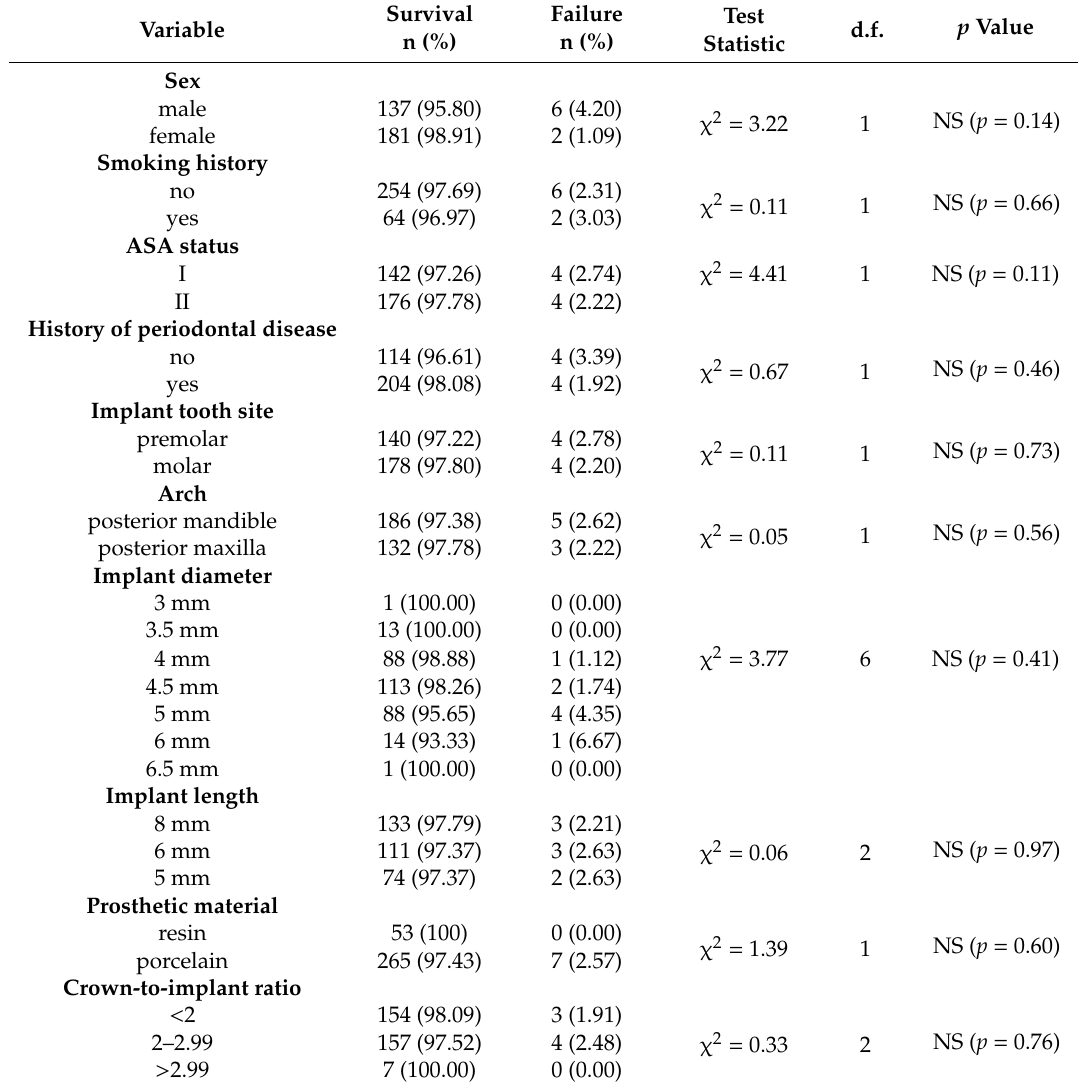
Table 3. Analysis of implant survival according to study covariates included. For all variables, values are presented as n (%); NS = not statistically significant; d.f. = degrees of